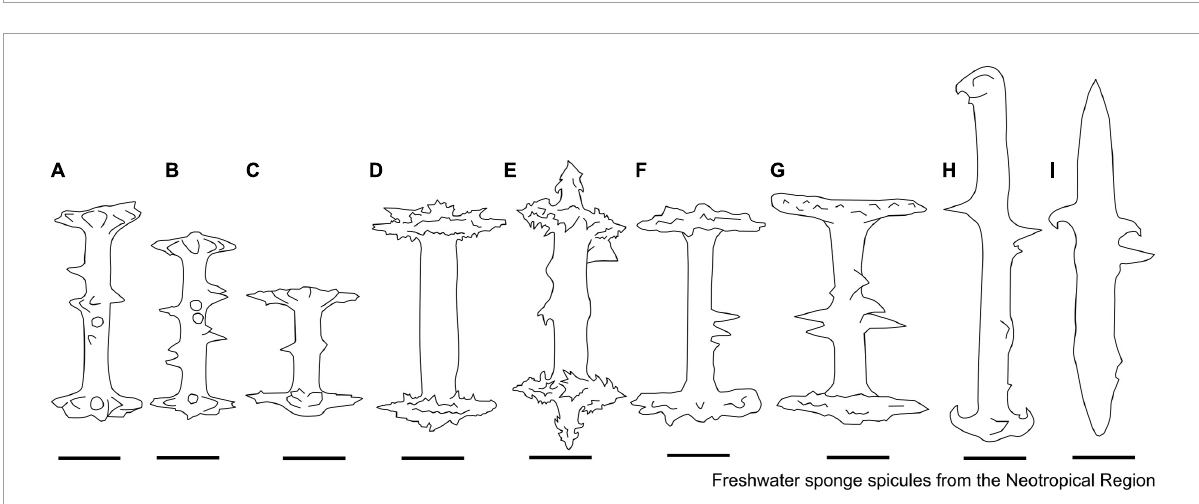
Spicules: Megascleres are stout, smooth oxeas, with abruptly pointed extremities. Microscleres are slender, slightly curved, spiny oxeas, all spines capped by a rosette of microspines ( Figure 8J ). Gemmuloscleres are short, stout, spiny oxeas, straight to slightly curved, covered by large spines curved toward the middle part of the spicule, and their extremities split into a few smaller spines ( Figure 8I